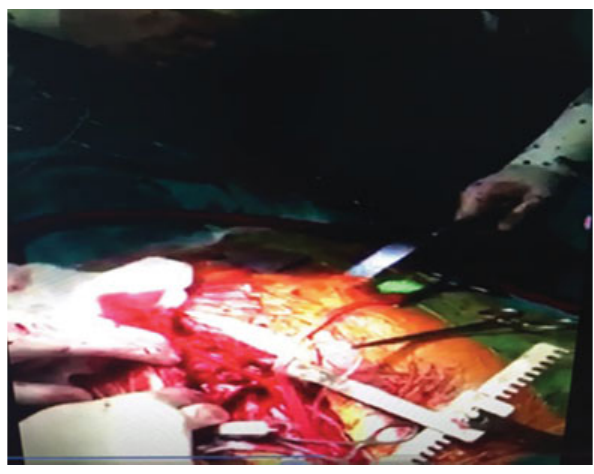
Fig. 4 Intraoperative moment of metal strut removal.